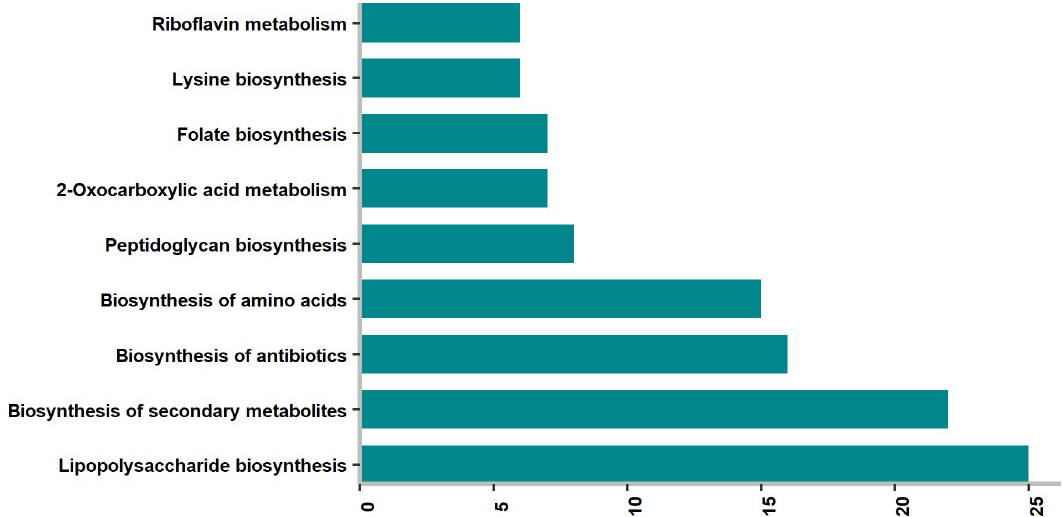
Fig 2. Pathway enrichment analysis result. The values on the x axes indicates number of drug targets in the related pathway with no homology to human proteins.